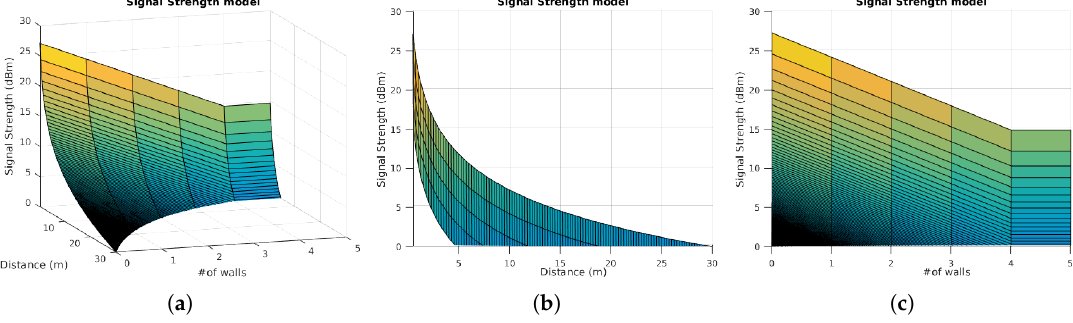
Figure 2. Behaviour of the signal strength model. ( a ) The signal strength function Γ i (dBm) is plotted for a [0..5] range of walls and [0..30] (m) range of distances; ( b ) Attenuation caused by distance; ( c ) Attenuation caused by wall